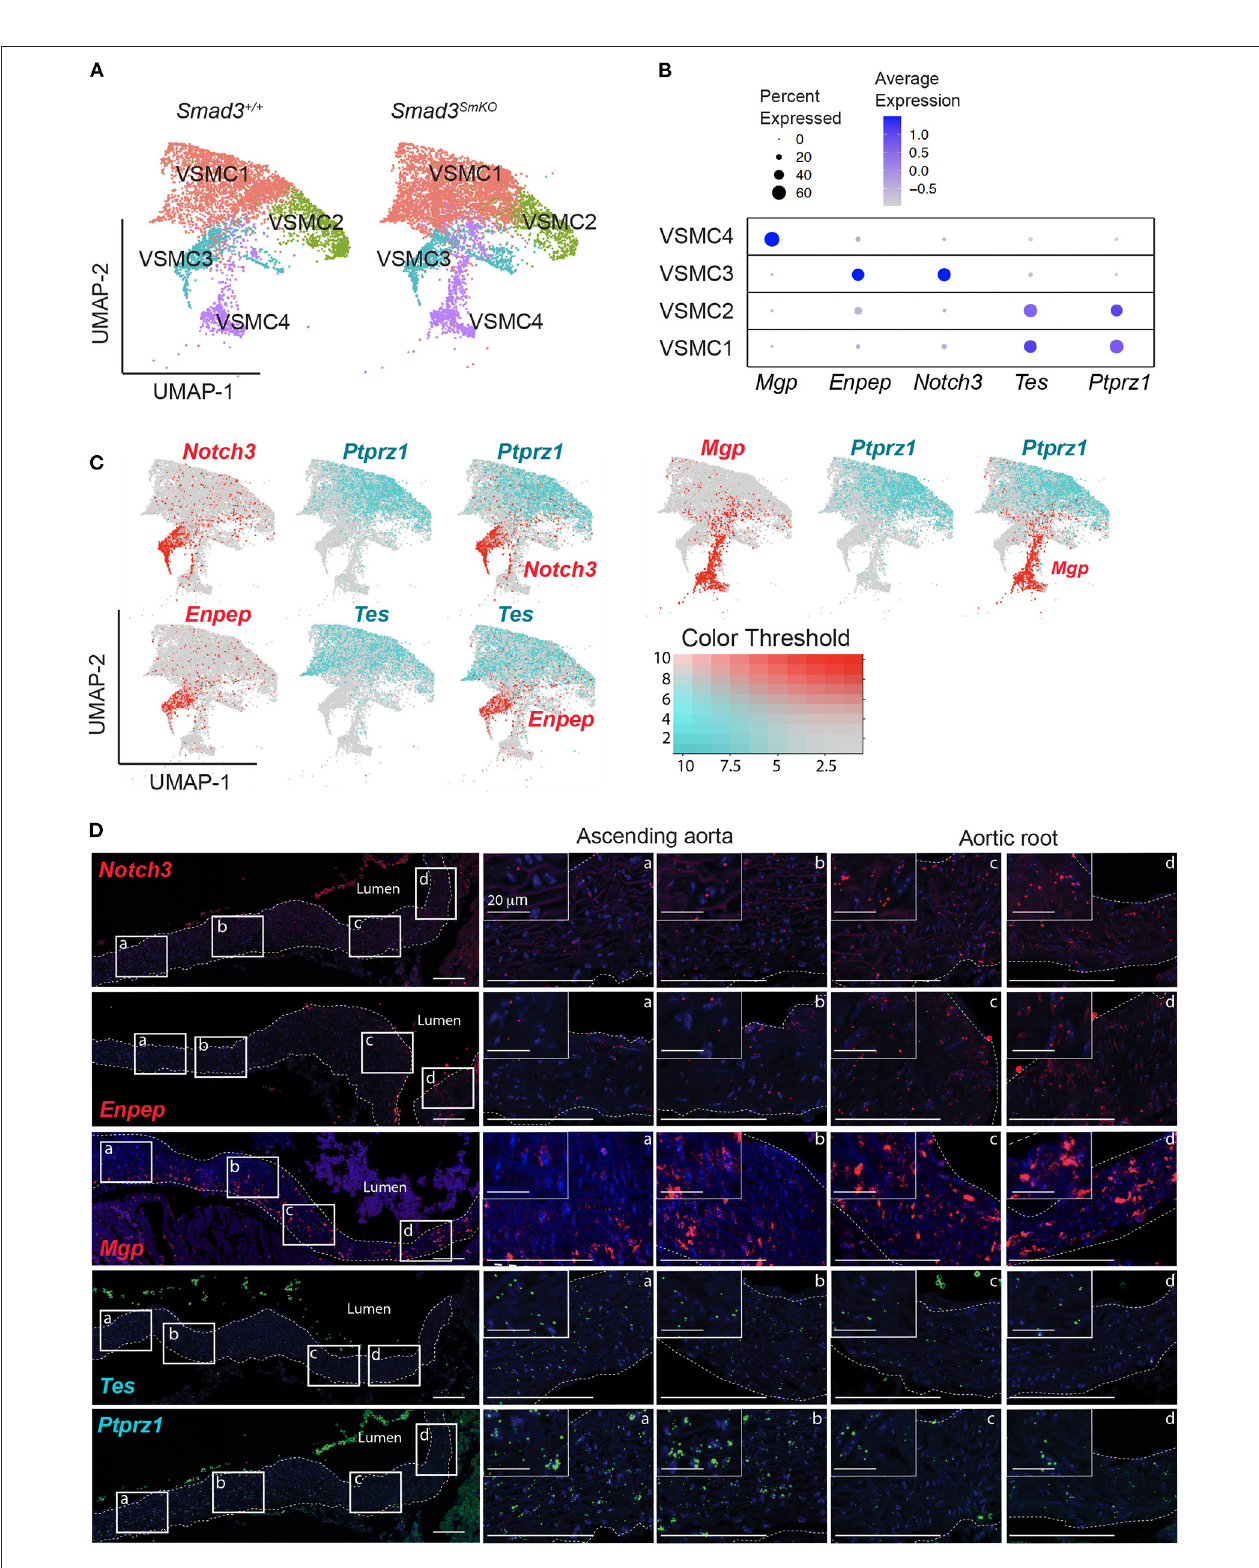
FIGURE 6 | Single cell transcriptomic analysis reveals four subpopulations of VSMCs and a gradient of cluster-defining transcripts that define the proximal to distal location in the murine aorta. (A) Uniform manifold approximation and projection (UMAP) of vascular smooth muscle cells (VSMCs) from Smad3 + / + and Smad3 SmKO aortas reveals four subclusters irrespective of genotype. (B) Dot plot showing expression of cluster-defining transcripts for the VSMC